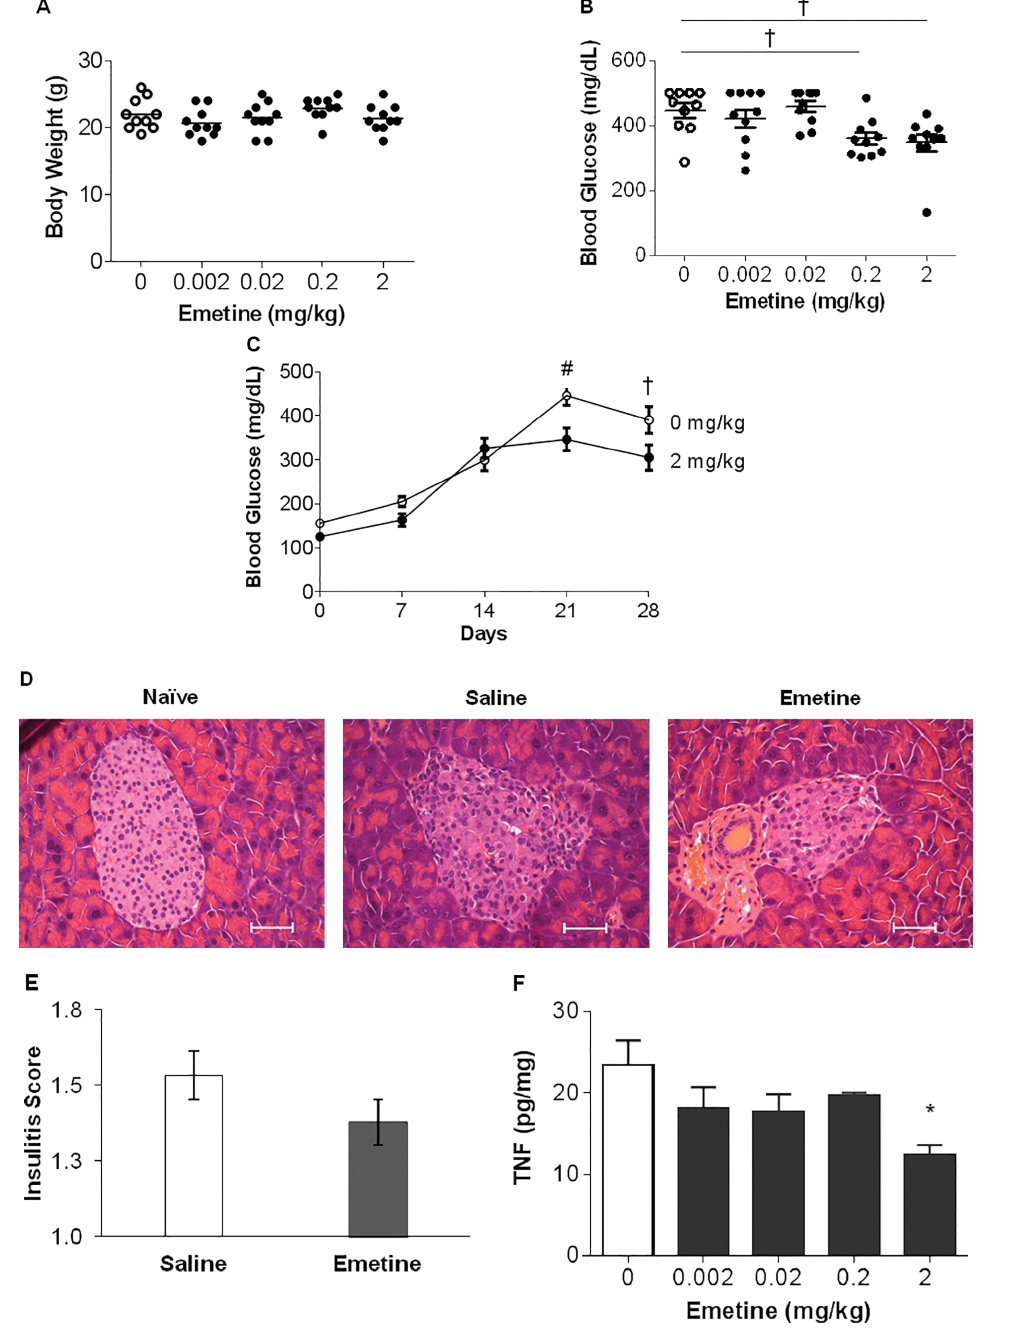
Figure 4. Emetine improves disease severity in a streptozotocin model of T1D. (A) Emetine administration did not induce any significant changes in body weight. Body weights collected at the end of the study are shown here. (B) Emetine administration attenuated blood glucose levels in a dose dependent manner. Blood glucose measured at d 21 in all the dose groups is shown here. (n = 10/group, one way ANOVA: † p < 0.01) (C) Emetine (2 mg/kg) induced a persistent attenuation of blood glucose levels. Data are mean ± SEM. (n = 10/ group, two way ANOVA: † p < 0.01, # p < 0.0001). (D) Representative images of hematoxylin and eosin stained pancreatic islets from mice receiving saline or emetine (2 mg/kg). Islet from a naïve animal is shown as a representation of a normal islet. Scale bar-50 μ m. (E) Emetine (2 mg/kg) induces decrease in insulitis severity. Data are mean ± SEM. (n = 5; islets: saline = 81 and emetine = 53, Student t -test, p = 0.72). (F) Emetine induces significant attenuation of pancreatic TNF levels. Data are mean ± SEM. (n = 10/group, one way ANOVA: * p <